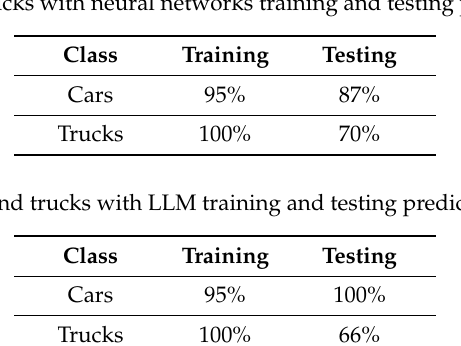
Table 4. Cars and trucks with neural networks training and testing prediction accuracy.